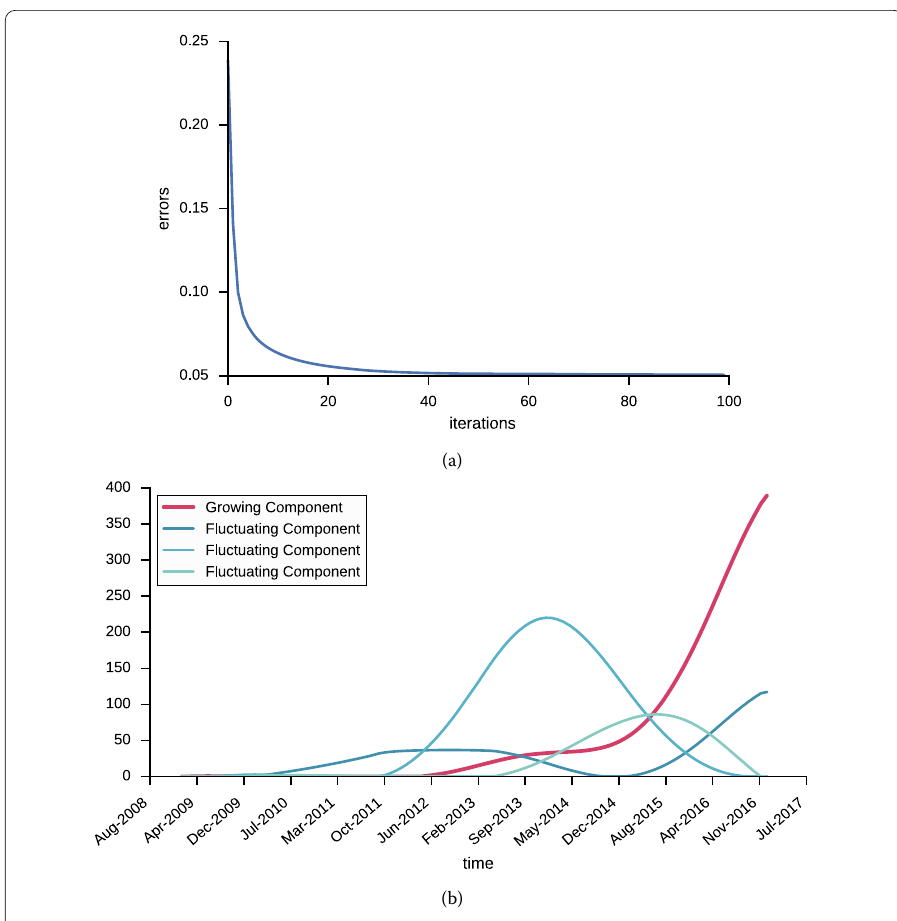
Figure 5 Output of the factorization of the matrix representing the Bitcoin search time series. ( a ) Reconstruction error with respect to the number of iterations. The reconstruction error is given by the Frobenius norm of the matrix difference between the original and the approximated matrices. ( b ) Representation of the principal components with k = 4. The growingcomponent (red) represents the trend of the new adopters. The other 3 components are the fluctuating ones, and mostly represent what we call the early